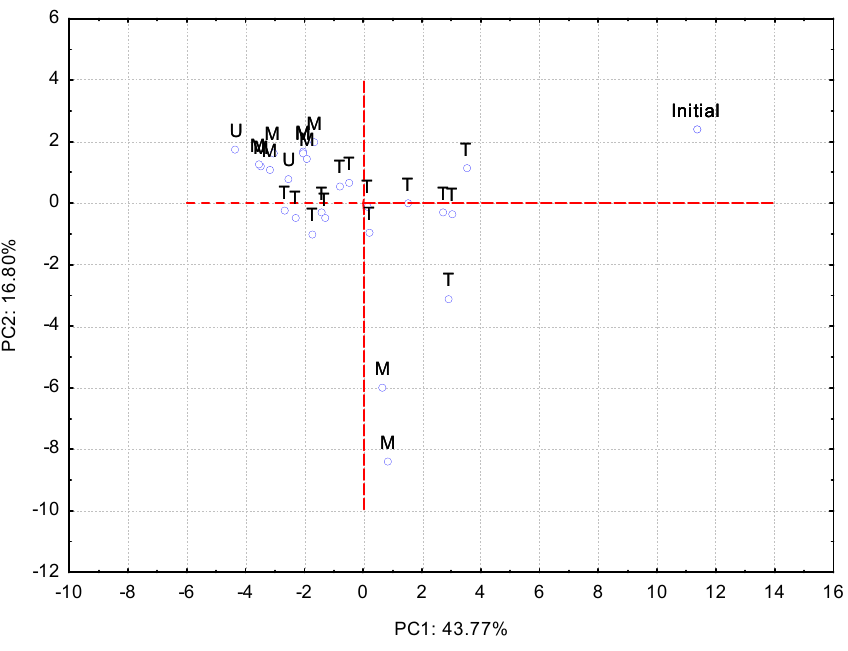
Figure 3. Principal component analysis of the samples subjected to the different maceration proce- dures. U: ultrasound; T: traditional; M: microwave. Initial: unmacerated vinegar. Five of the principal components obtained had an eigenvalue >1 and explained 99.94% of the variation between samples. Component 1 (PC1) explained 43.77% while component 2 (PC2) explained 16.80% of the variability. PC1 was able to separate the samples that were subjected to maceration with pineapple from the initial sample, that had not been macerated. As can be seen in Table 6, the 5 compounds that were most relevant to this component were: methyl salicylate, ethyl phenyl acetate, 2-phenethyl acetate, benzenemethanol, and 4-ethylphenol, of which 2-phenethyl acetate is closely related to pineapple aroma [30]. Therefore, as expected, it was confirmed that maceration with pineapple greatly modifies the volatile profile of the resulting vinegar, with some pineapple-derived compounds as clear markers of the macerated samples. Table 6. Contribution of volatile compounds studied to the first two PC (values >